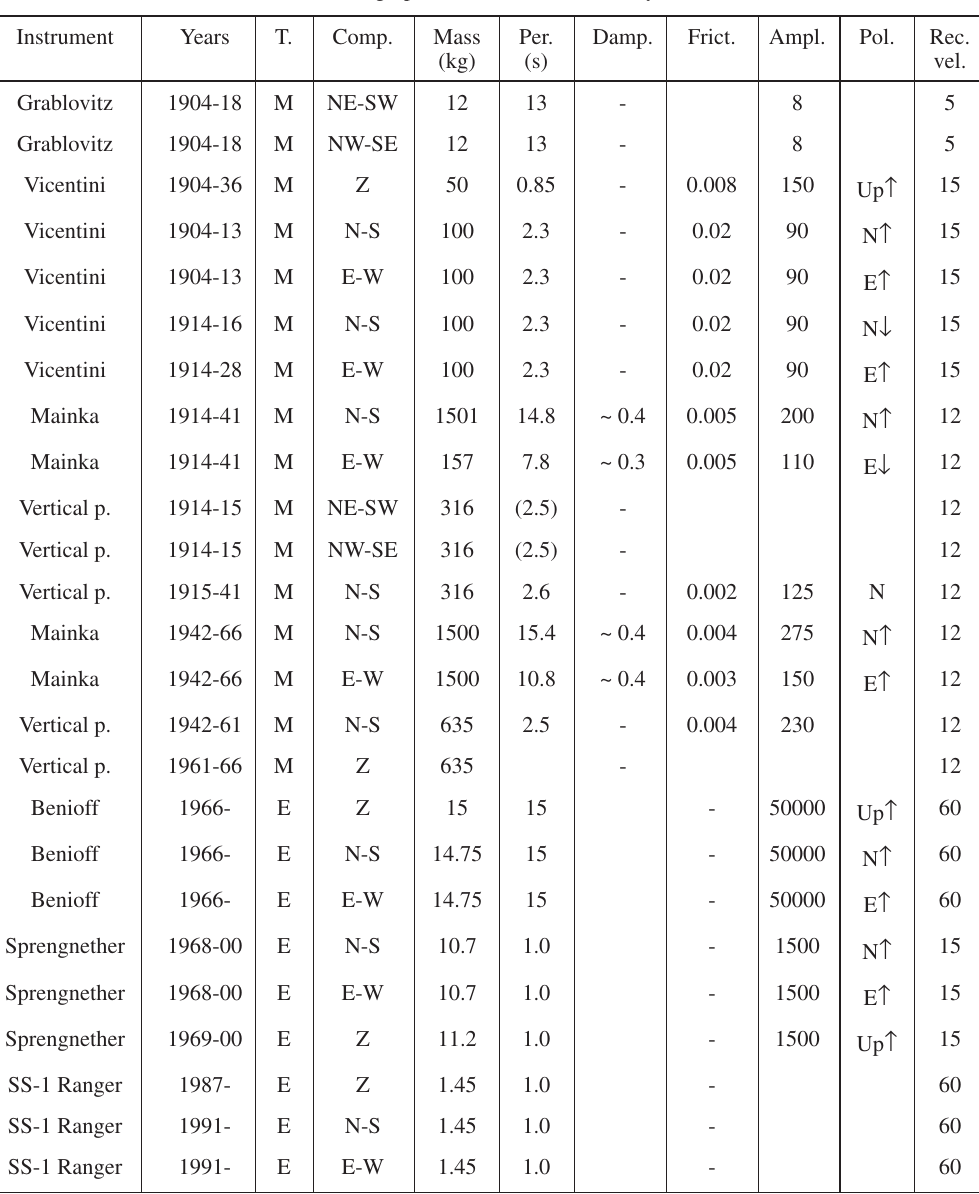
Table I. Different seismographs that have operated at the Ebre Observatory together with their characteristics: name of the seismograph, time period of operation, type (M: mechanical; E: electromagnetic), component, mass of the pendulum, period, damping factor, friction factor, amplifi cation factor, polarity and recording velocity in millimetres per minute (Batlló and Ugalde, 2000). Values in brackets are not known